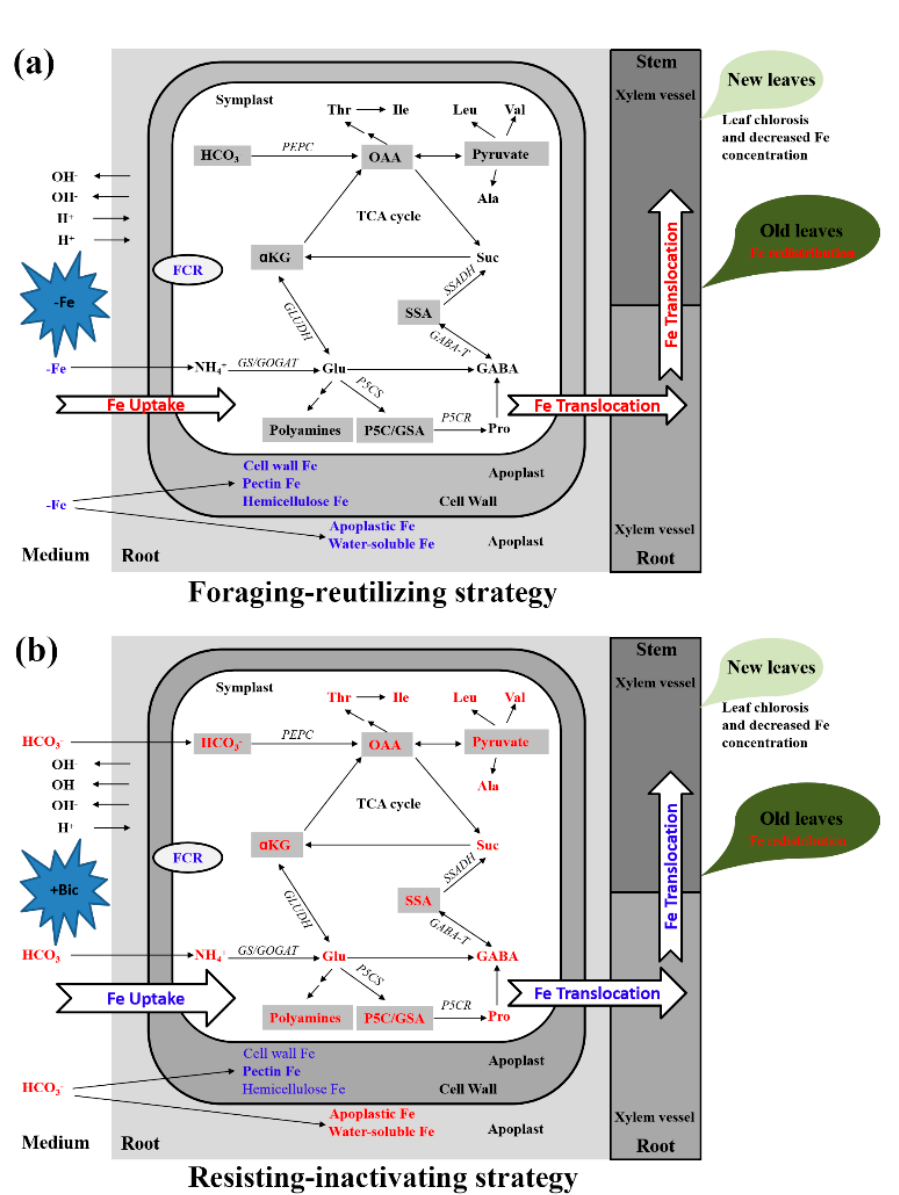
Figure 5. A model for Fe uptake and translocation in kiwifruit plants under direct Fe deficiency (-Fe) ( a ) and bicarbonate-induced Fe deficiency ( + Bic) ( b ) conditions. Red and blue-colored parameters or processes represent positive and negative e ff ects, respectively. Gray-shaded parameters in symplast space represent these parameters not identified in the current study. Parameters not in bold indicate these parameters less a ff ected by -Fe and + Bic stresses. The thicker of the arrow representing Fe uptake and translocation, the higher of Fe amount contained. Ala, alanine; α KG, α -ketoglutarate; FCR, ferric chelate reductase; GABA, γ -aminobutyric acid; GABA-T, γ -aminobutyric acid transaminase; Glu, glutamic acid; GLUDH, glutamate dehydrogenase; GS / GOGAT, glutamine synthetase / glutamate synthase; Ile, isoleucine; Leu, leucine; OAA, oxaloacetic acid; P5C / GSA, pyrroline-5-carboxylate / glutamate-semialdehyde; P5CR, pyrroline-5-carboxylate reductase; P5CS, pyrroline-5-carboxylate synthase; PEPC, phosphoenol pyruvate carboxylase; Pro, proline; SSA, succinic semialdehyde; SSADH, succinic semialdehyde dehydrogenase; Suc, succinic acid; TCA, tricarboxylic acid; Thr, threonine; Val, valine.